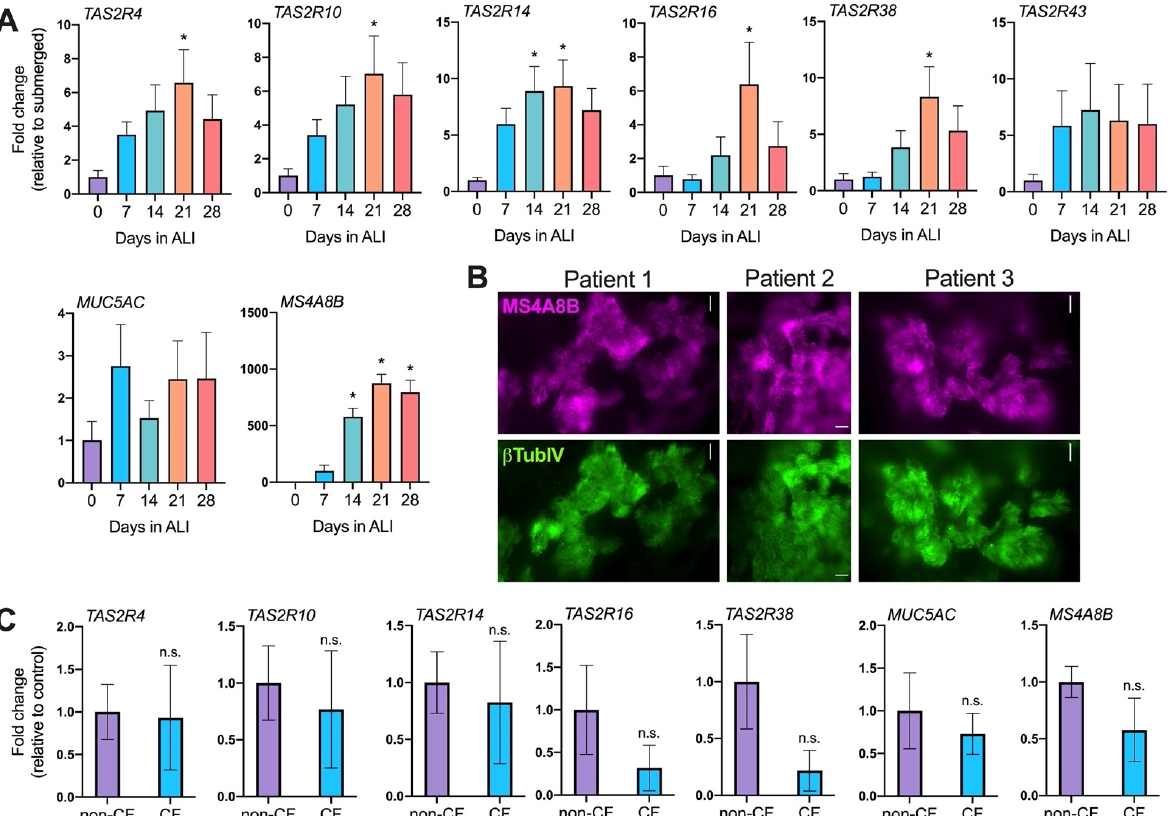
Figure 2. T2R expression in primary nasal air–liquid interface (ALI) cultures. ( A ) T2R expression increases during differentiation of nasal ALIs. Ciliary T2Rs, 4, 10, 14, 16 and 38 mRNA expression increased with at least 3 weeks of differentiation, as revealed by qPCR. Note that T2R receptors are encoded by corresponding TAS2R genes. Data points represent the average of 5 patients; signifi- cance was analyzed by one-way ANOVA using Dunnett’s post-test (* p < 0.05). ( B ) Immunofluores- cence of MS4A8B (Mouse monoclonal antibody 3E6, Kerafast, Boston, MA) and β -tubulin IV (Rabbit monoclonal EPR16775, Abcam) showing cilia co-localization. Representative images shown from 3 ALIs from 3 individual patients. ( C ) Cystic fibrosis does not alter T2R mRNA expression. Cilia- localized T2Rs 4, 10, 14, 16 and 38 did not significantly alter the expression when comparing nasal